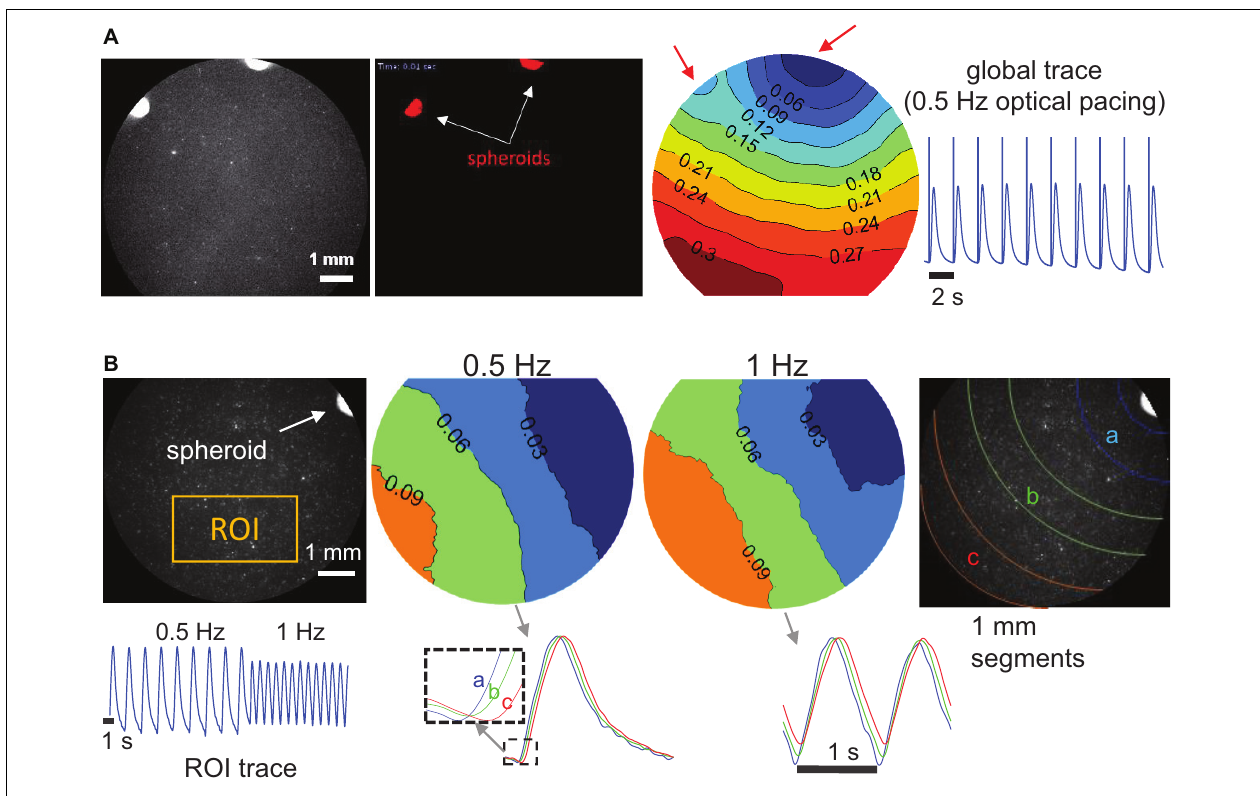
FIGURE 6 | Macroscopic optical mapping of optically triggered spheroid-mediated calcium waves in human iPS-CMs. (A) Calcium waves (by Rhod-4) triggered by optical light pulses at 0.5 Hz through a pair of spheroids after 24 h integration. Activation map shows the origin of early activation (blue), red arrows indicate the locally triggered activity by the two spheroids; isochrones are 0.03 s apart. Global calcium transients and the superimposed optical pulses are shown on the right. (B) Calcium waves by optogenetic sensor R-GECO, triggered at 0.5 and at 1 Hz through a single spheroid (after 24 h integration). In the activation maps (isochrones 0.03 s apart) slight wave-slowing is visible at the higher pacing frequency. At the bottom, an ROI trace is shown for the uninterrupted pacing and traces from different segments away from the spheroid illustrate sequential activation (a, b, and c). Scale bar is 1